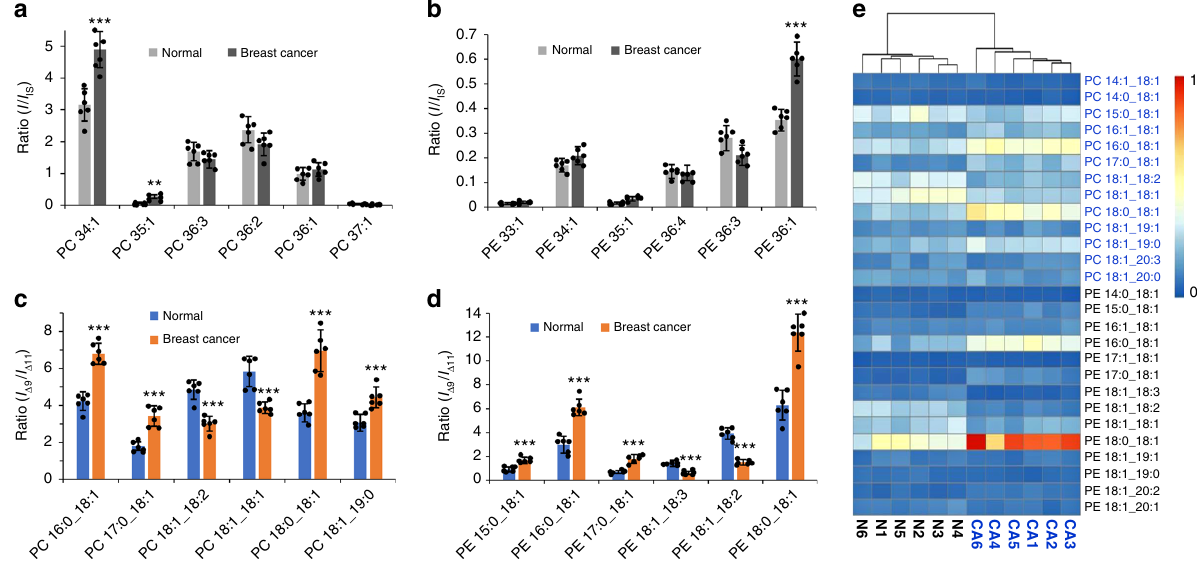
Fig. 3 Analysis of GPs containing C18:1 Δ 9/ Δ 11 isomers in human breast cancer samples. Relative quantitation of a PCs and b PEs at subclass level between normal and cancerous breast tissue samples by LC – MS/MS (PC 15:0/15:0 and PE 15:0/15:0 used as internal standards). Relative isomer compositional analysis of C18:1 Δ 9/ Δ 11 for c PC and d PE between normal and cancerous breast tissue samples by LC – PB – MS/MS. Differences between the two groups of samples were evaluated for statistical signi fi cance using the two-tailed student ’ s t test (* P < 0.05, ** P < 0.01, *** P < 0.001). Each value represents the mean ± s.d. ( N = 6). e Hierarchical cluster analysis based on C18:1 Δ 9/ Δ 11 ratios of 29 pairs of PC and PE isomers in normal (N1 – N6) and cancerous breast tissue samples (CA1 – CA6). Colors represent different ratios as indicated by the color